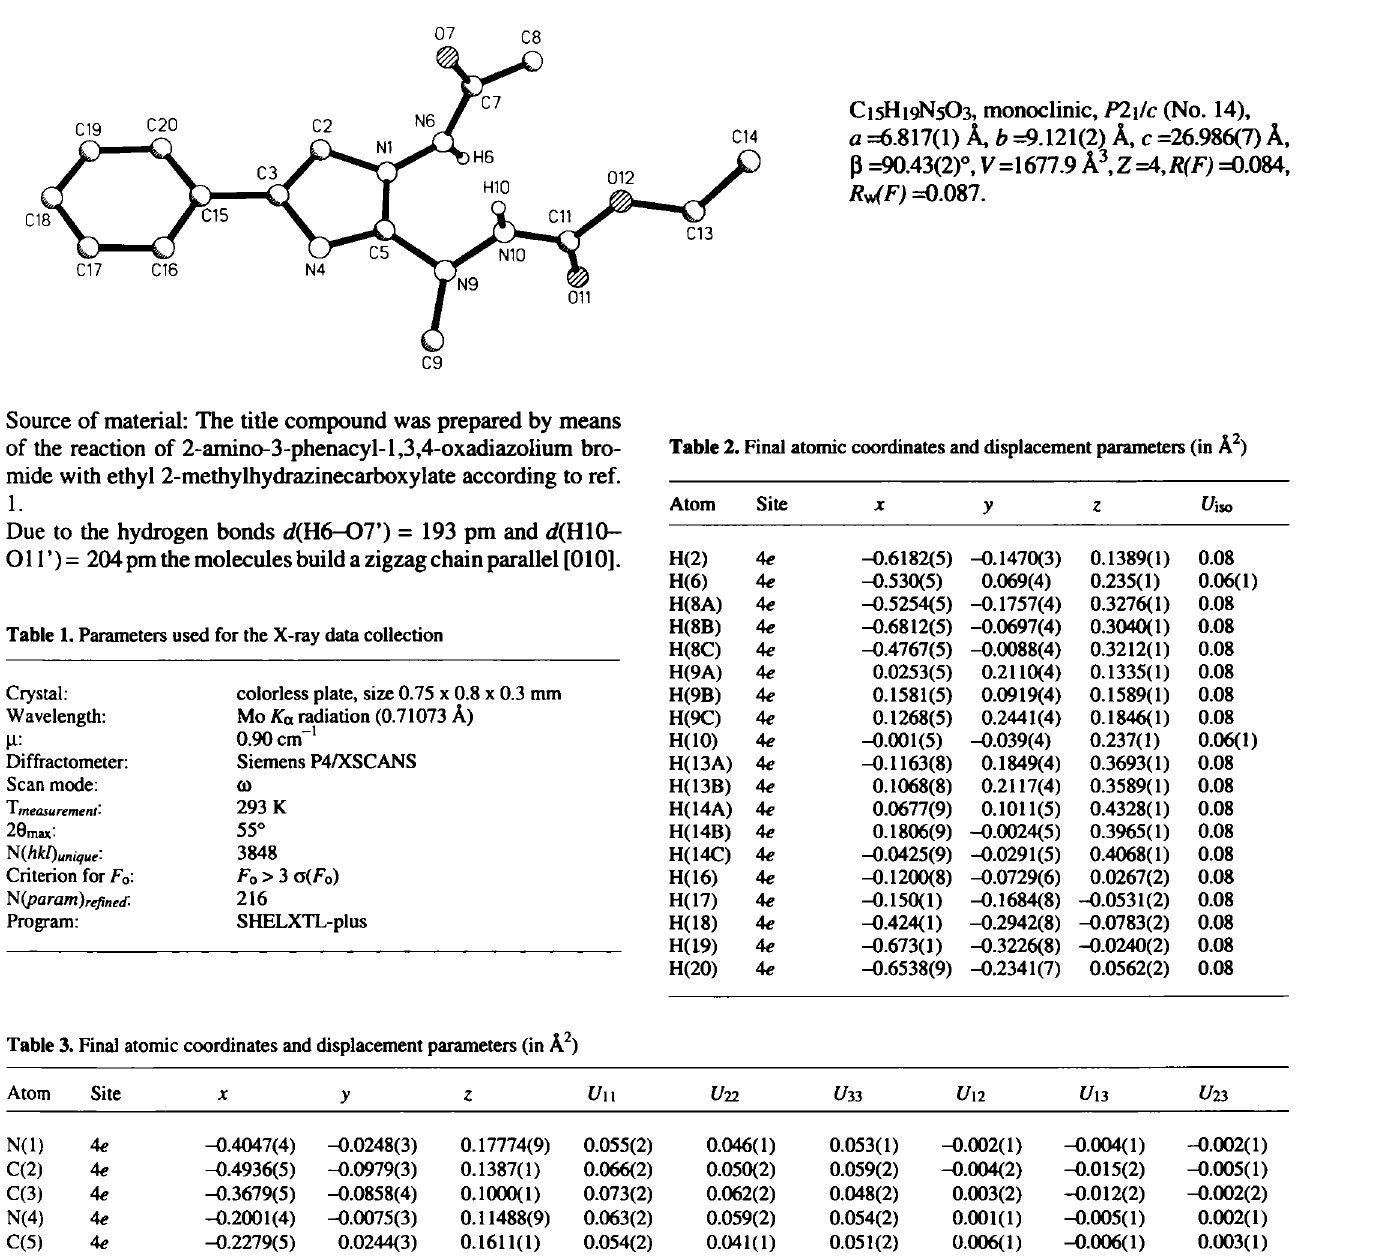
Table 3. Final atomic coordinates and displacement parameters (in À^) Atom